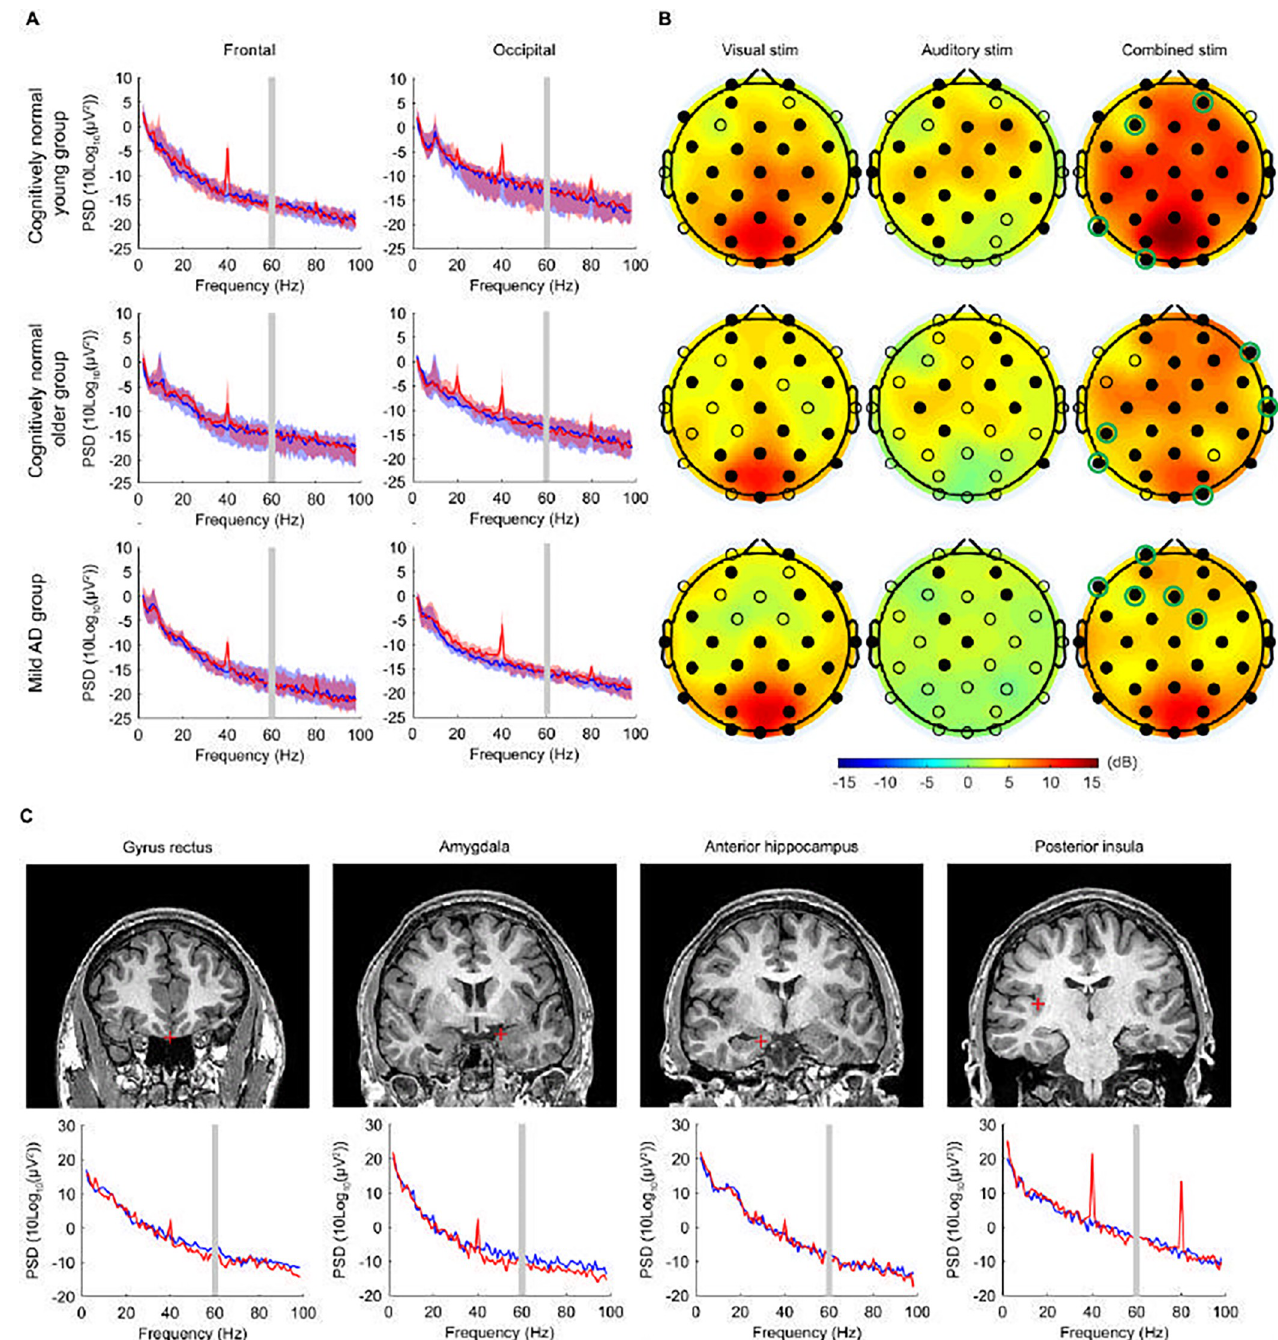
Fig 3. Acute 40Hz combined visual and auditory stimulation entrains cortical and subcortical regions. (A) Scalp EEG power spectral density (PSD) at the frontal (Fz, F3, F4, F7, F8) and the occipital (Oz, O1, O2) electrode sites, in cognitively normal young participants (n = 13; top row), cognitively normal older participants (n = 12; middle row), and patients with mild AD (n = 16; bottom row). Solid lines, group median; shaded areas, 95% confidence interval; blue, baseline; red, 40Hz GENUS light and sound stimulation (active condition). Gray bar indicates 60 Hz line noise. (B) Topographic maps showing the median change in 40Hz PSD from the baseline level with 40Hz visual alone, 40Hz auditory alone, and 40Hz combined stimulation, in cognitively normal young participants (n = 13; top row), cognitively normal older participants (n = 12; middle row), and patients with mild AD (n = 16; bottom row). Filled circles represent scalp electrodes at which the increase in 40Hz PSD from the baseline level was significant (p < 0.05, Wilcoxon’s sign rank test, Bonferroni corrected for 32 electrodes). Green circles indicate electrodes entrained with synchronized 40Hz GENUS light and sound stimulation but not by light or sound alone. (C) Example coronal MRI images before electrode implantation (top row) and intracranial EEG PSD (bottom row) from a single patient with medically intractable epilepsy (Patient 483), for depth electrode contacts placed in the gyrus rectus, amygdala, anterior hippocampus, and posterior insula. Red plus sign,